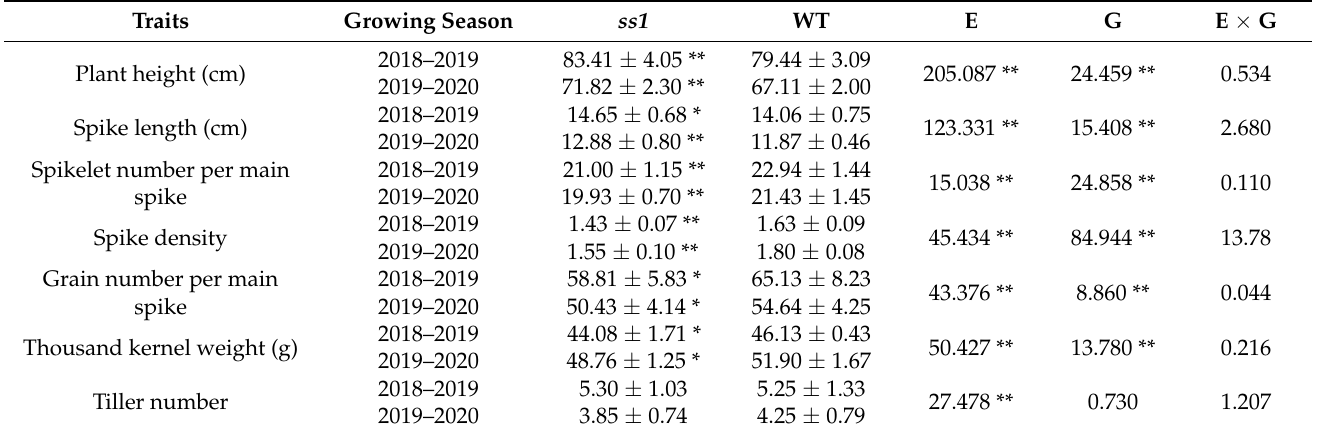
Table 2. Comparison of the processing quality parameters of the mutant ss1 and the wild-type (WT) control.